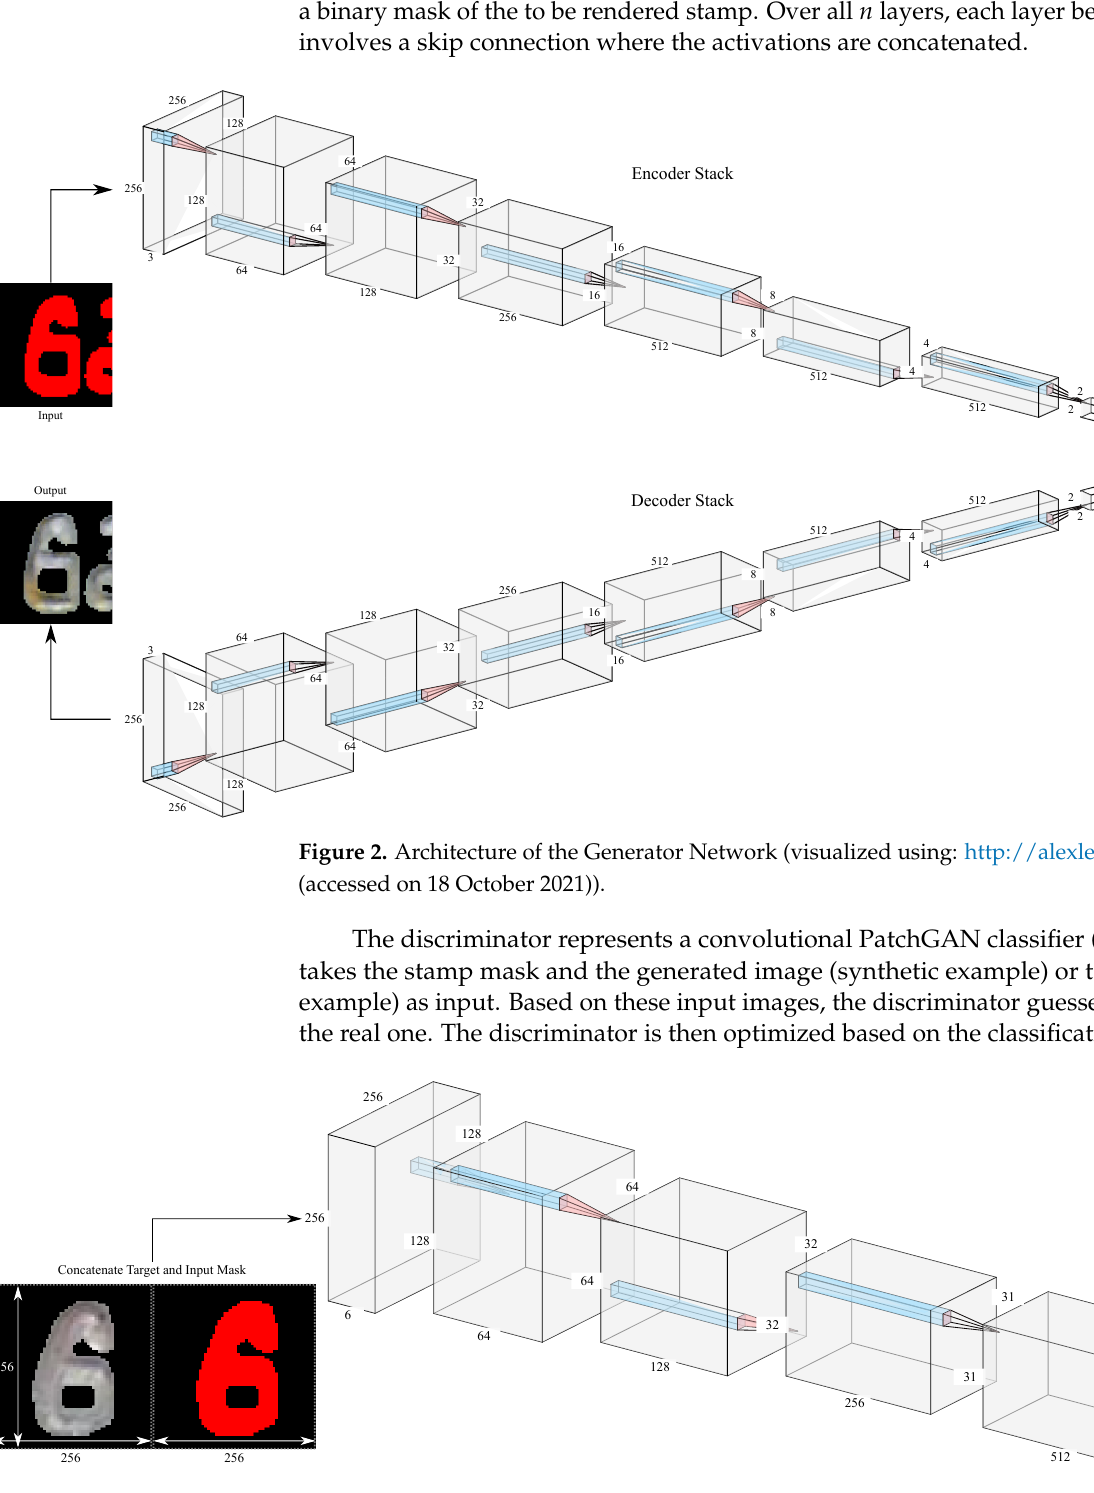
Figure 3. Architecture of the Discriminator Network (visualized using: http://alexlenail.me/NN-SVG/ (accessed on 18 October